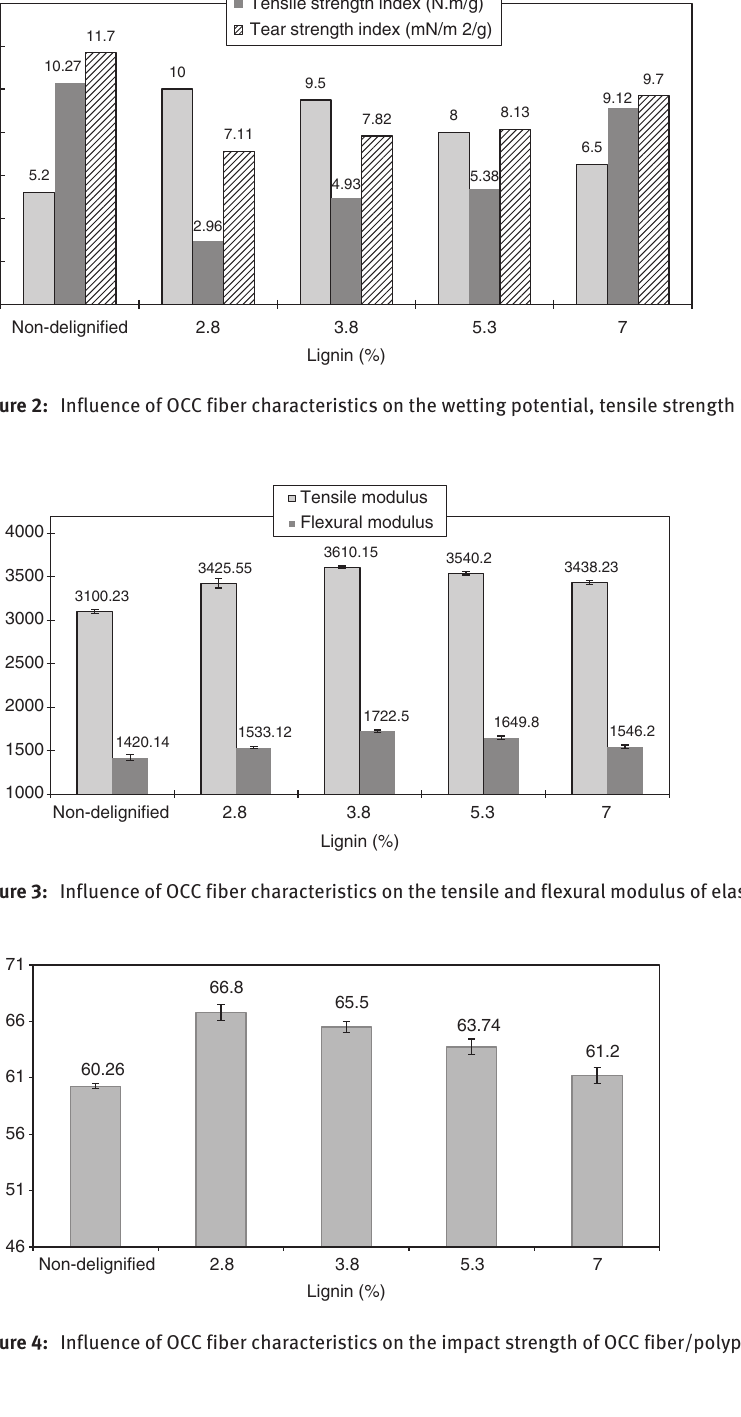
values were reached. However, a positive correlation between fiber wettability and composite strength was observed. As either the tensile strength or the tear strength of the fibers increases, as measured by tear and tensile strength of thin hand sheets of the paper, a